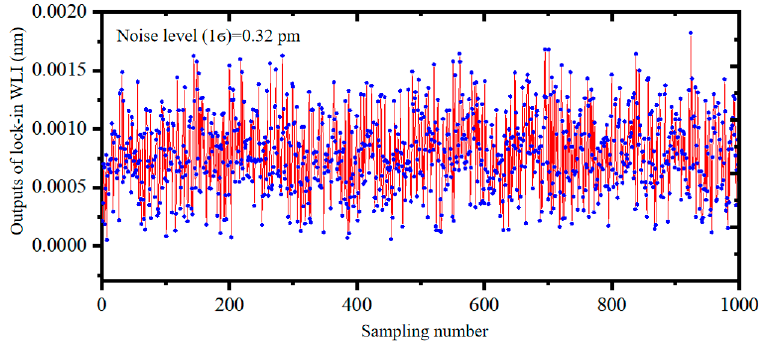
Figure 10. The background noises with the SPAC filled with pure N 2 gas.